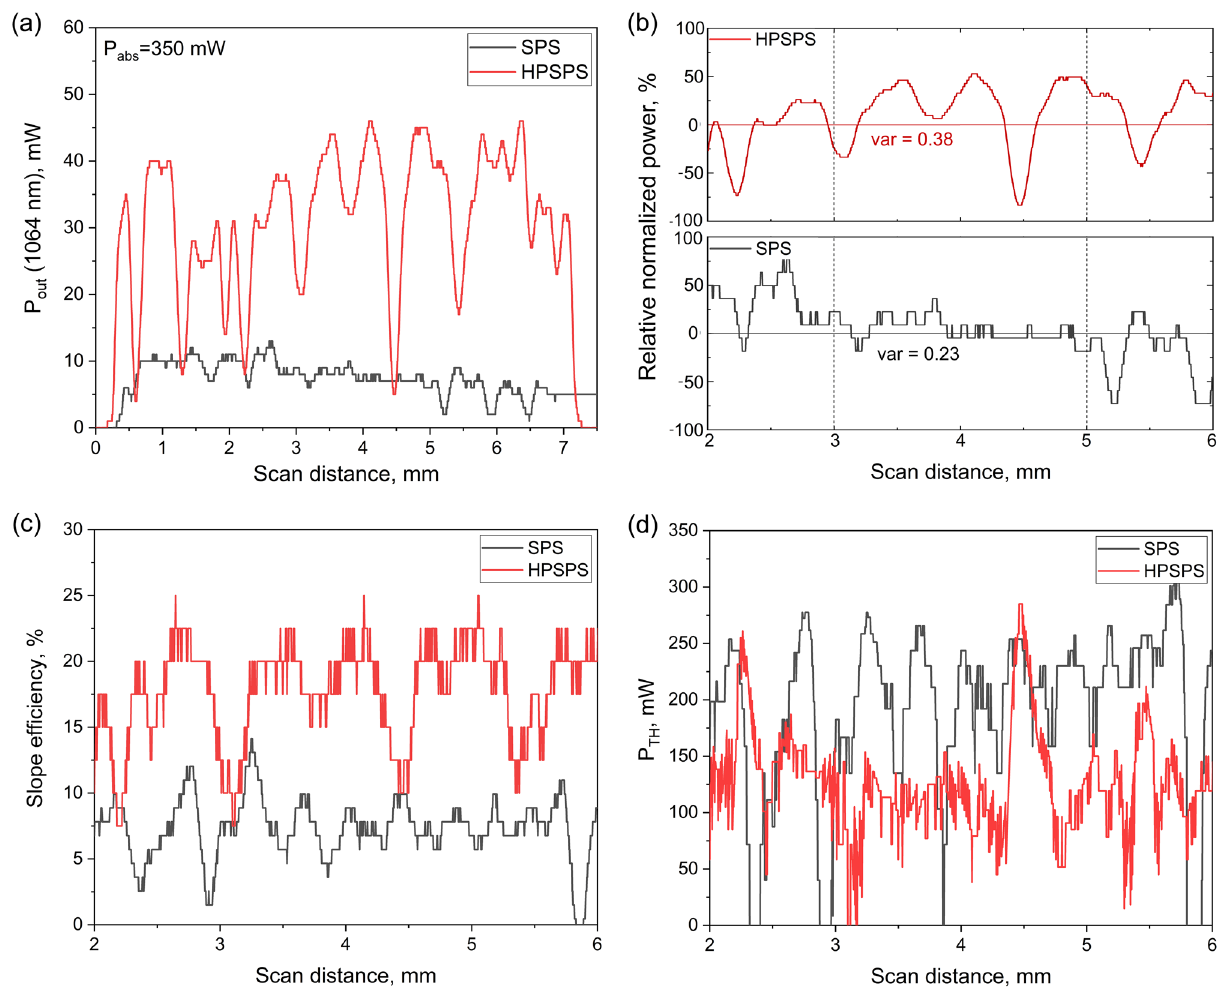
Figure 4. Plots for 0.9 mm, 1.5 at% Nd SPS- (black) and HPSPS-(red) processed samples, a comparison of ( a ) output power for the same absorbed power, ( b ) relative normalized power, calculated from three output power versus absorbed power plots, ( c ) slope efficiency and ( d ) threshold